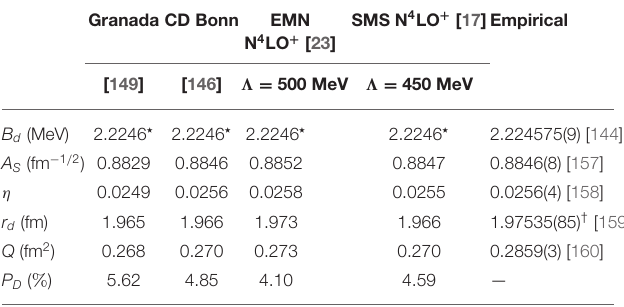
TABLE 2 | Deuteron binding energy B d , asymptotic S-state normalization A S , asymptotic D/S-state ratio η , radius r d , quadrupole moment Q , and D-state probability P D as predicted by various high-quality